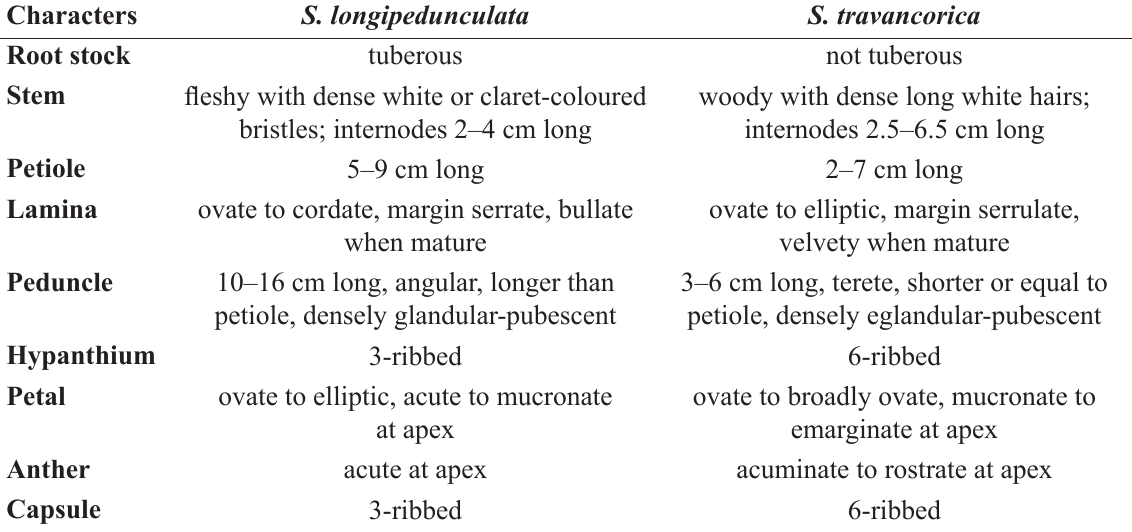
Table 1. Comparative morphological features of Sonerila longipedunculata Resmi & Nampy sp. nov. and S. travancorica